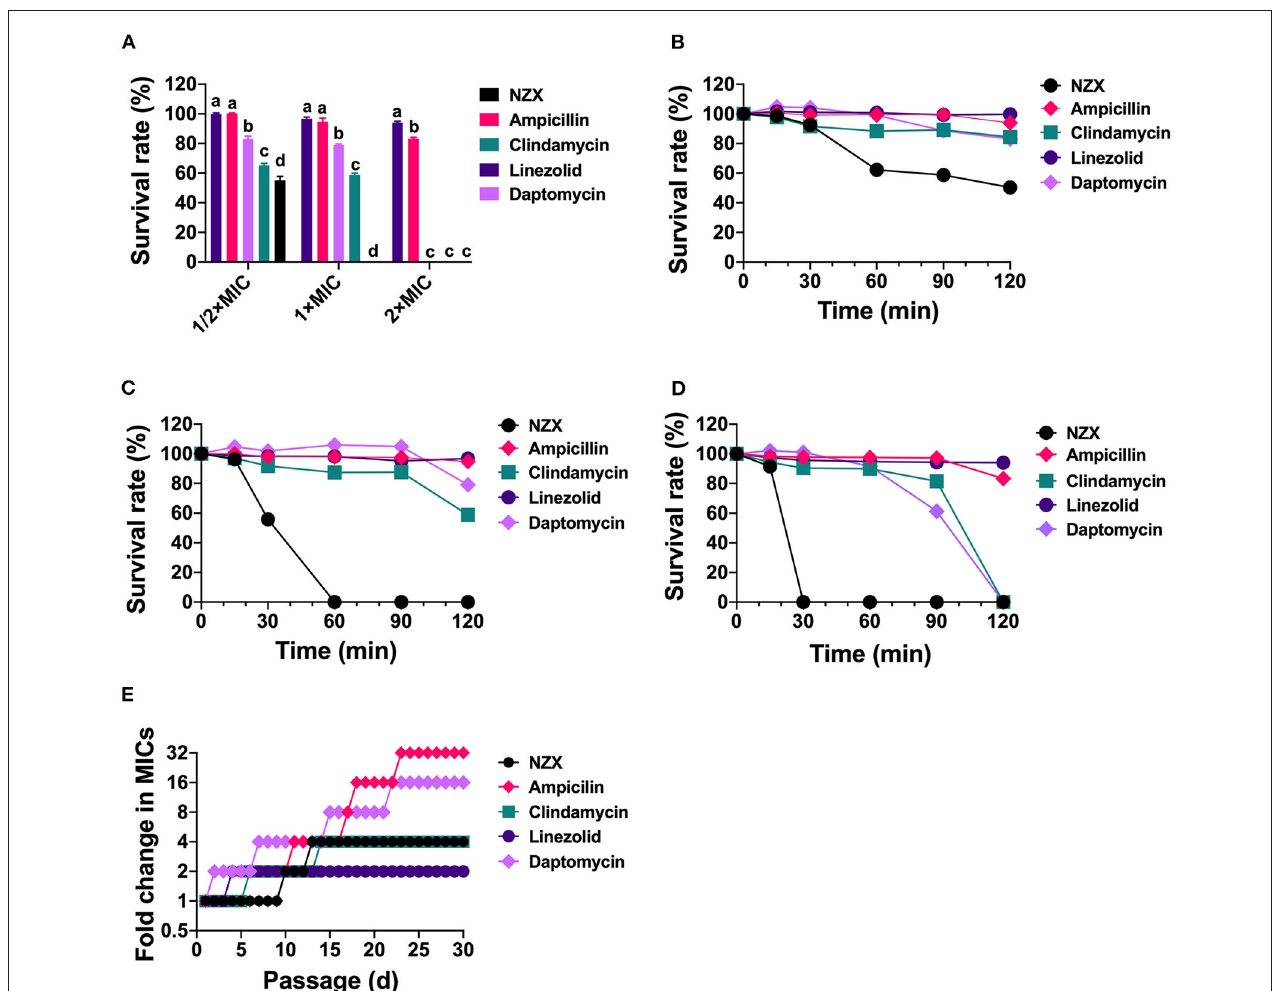
FIGURE 1 | The survival rate and development of drug resistance of S. aureus E48 in vitro . (A) The bacterial cell survival ratio of S. aureus E48 treated with linezolid, ampicillin, daptomycin, clindamycin, and NZX at 1/2 × MIC, 1 × MIC, and 2 × MIC for 120min. The statistical difference was conducted by one-way ANOVA, with Tukey’s multiple comparisons test. Values are expressed as mean ± SD ( n = 3), and different letters represent a significant difference in the same concentration ( p < 0.05). (B–D) The bacterial survival rate of S. aureus E48 treated with 1/2 × MIC (B) , 1 × MIC (C), and 2 × MIC (D) linezolid, ampicillin, daptomycin, clindamycin, and NZX for 120min. Values are expressed as means ± SD ( n = 3). (E) Development of drug resistance of S. aureus E48 repeated exposure to linezolid, ampicillin, daptomycin, clindamycin, and NZX for 30-day with sub-MIC